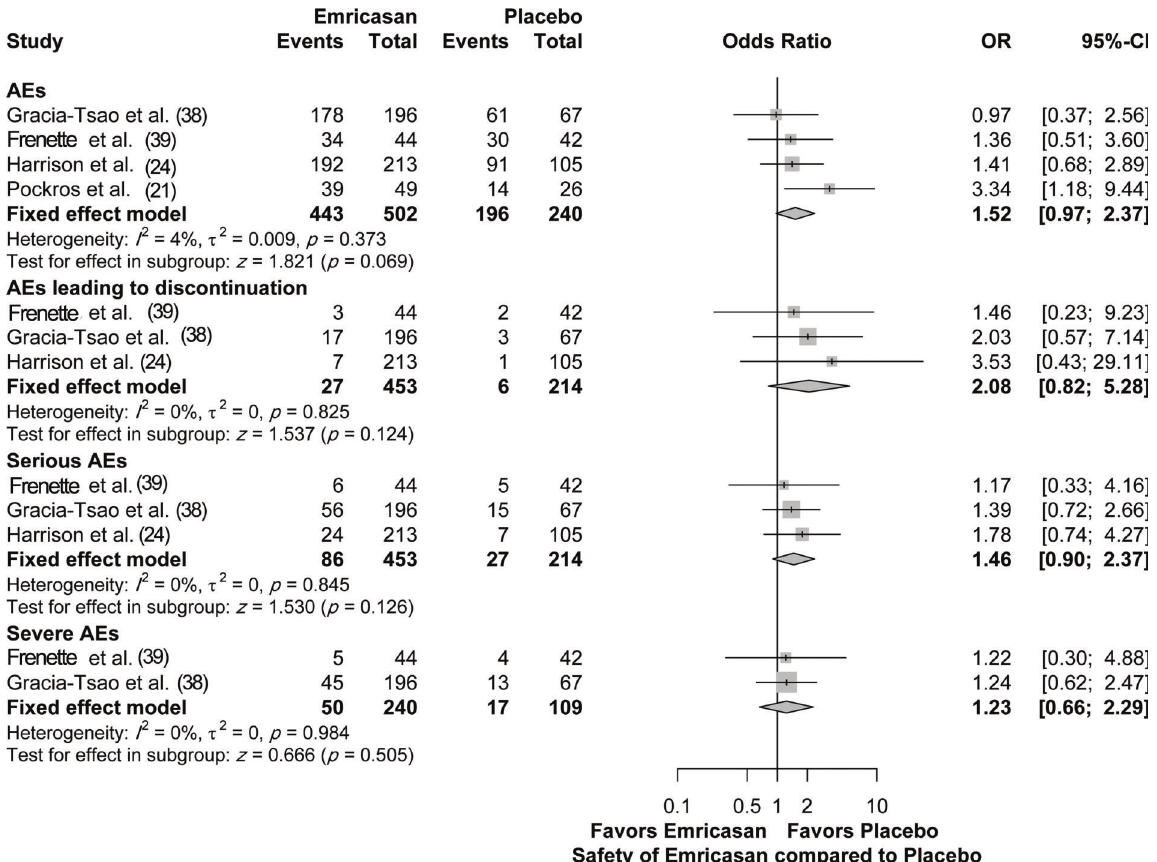
Figure 5 - Safety of emricasan treatment (all doses) compared to